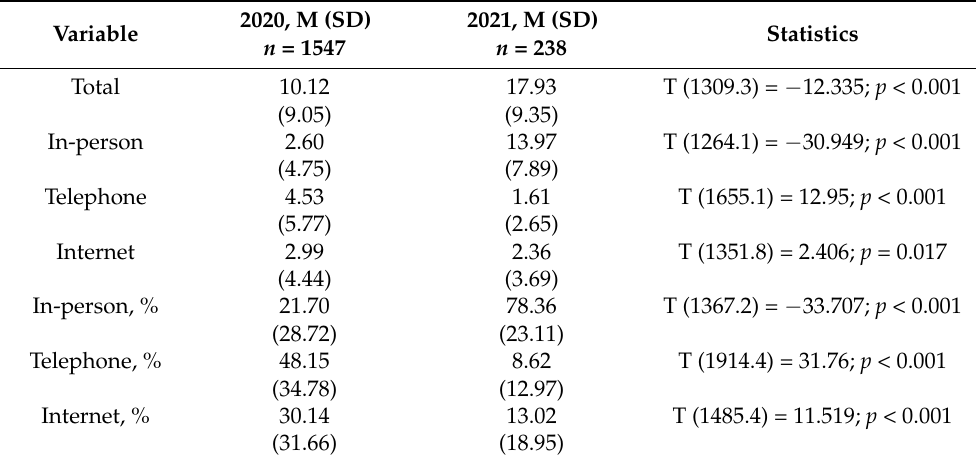
Table 2. Numbers of patients treated on average per week in 2020 vs. 2021 for the three treatment